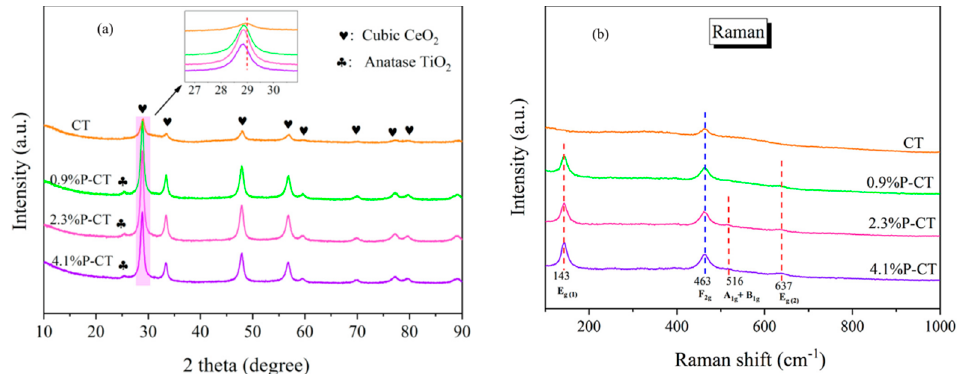
Figure 19. ( a ) XRD patterns of CT and phosphorus-loaded catalysts, ( b ) Raman spectra of CT and phosphorus-loaded catalysts [84].